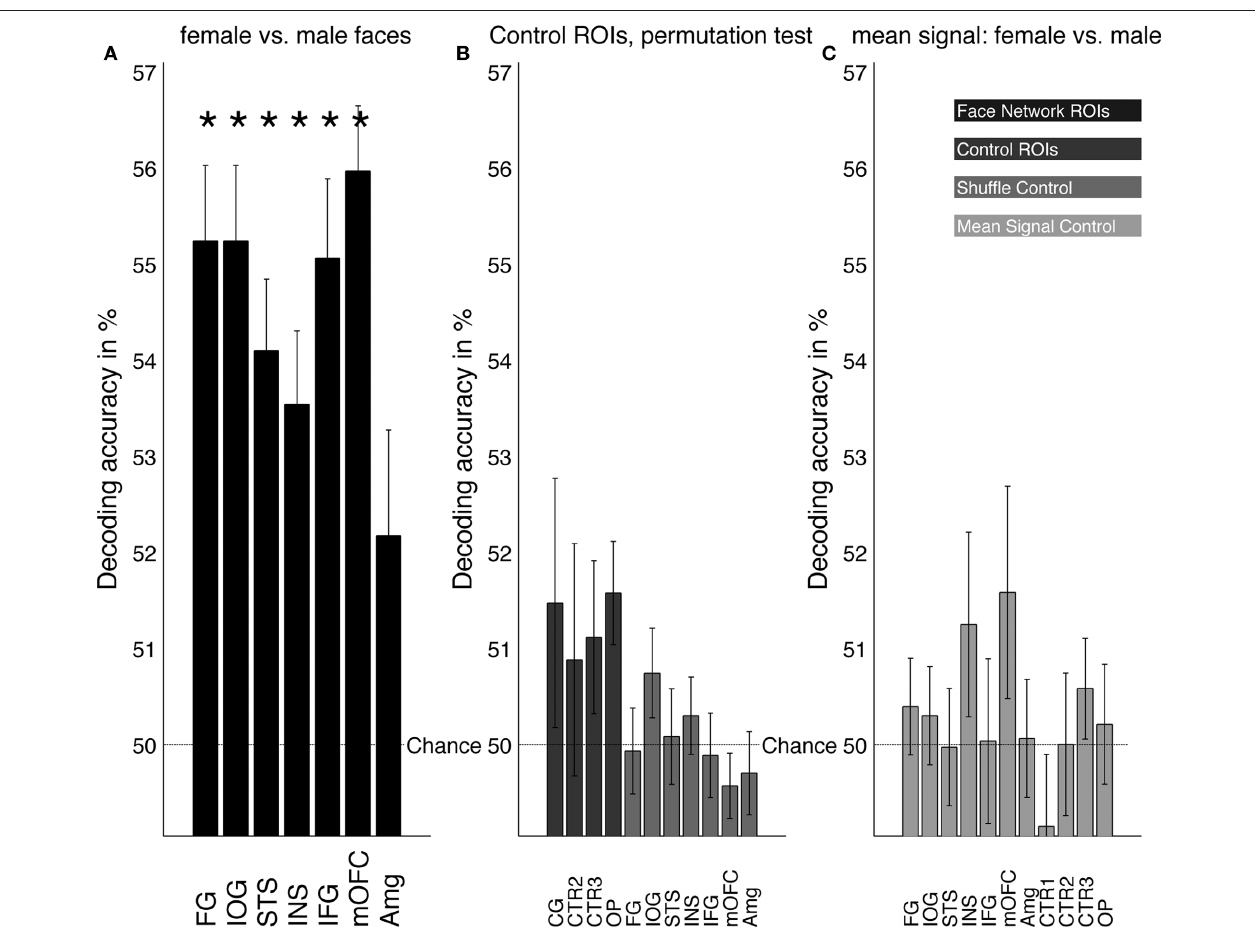
prediction (dark gray). Additionally, we performed a shuffle-control test (Mur et al., 2009) with randomly permuting labels for each set of test vectors in each cross-validation. Results of the permutation test were not significantly different from chance (medium gray). (C) Decoding analysis in all ROIs using the mean signal (one value per volume/ROI) instead of the pattern information within each ROI (light gray). Results were not significantly different from chance, suggesting that overall signal differences between blocks of male and female faces in individual participants cannot account for the decoding